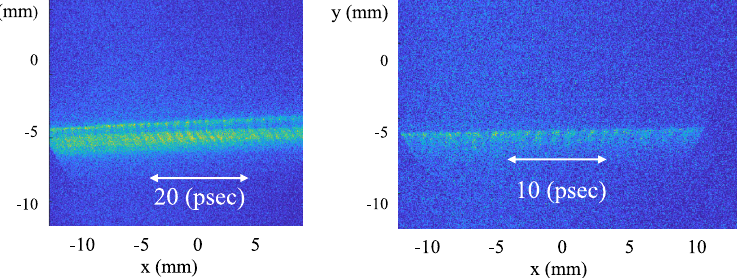
15. Raw images from the 1 ” YAG screen taken with (a) 100 kV and (b) 200 kV voltage in the SRF linac using 0.7 nC electron bunches. Three quadrupoles in front of the 45-degree dipole magnet were used to maximize the horizontal resolution. The measured horizontal dispersion of D ¼ 1 . 36 m at the YAG4 profile monitor provides for 0.37 and 0 . 75 mm = psec resolution for 100 and 200 kV linac voltages, respectively. The slice of electron beam seen at the screen corresponds to 65 psec in (a) and 32 psec in (b). Structures captured in these images are irregular with spectrum peaking around 0.5